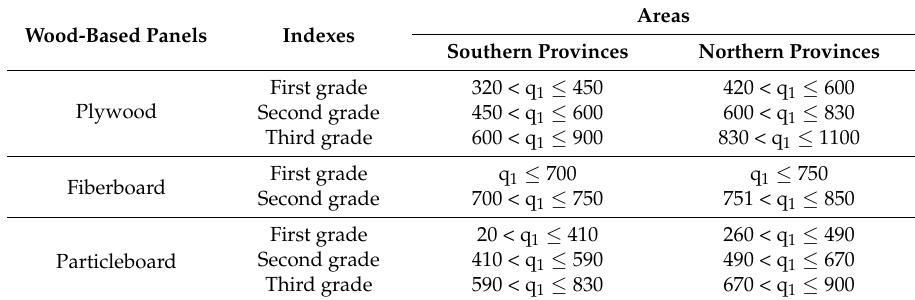
Table 1. Indexes of energy consumption for producing 1 m 3 of panels in the first stage (kgce/m 3 ).